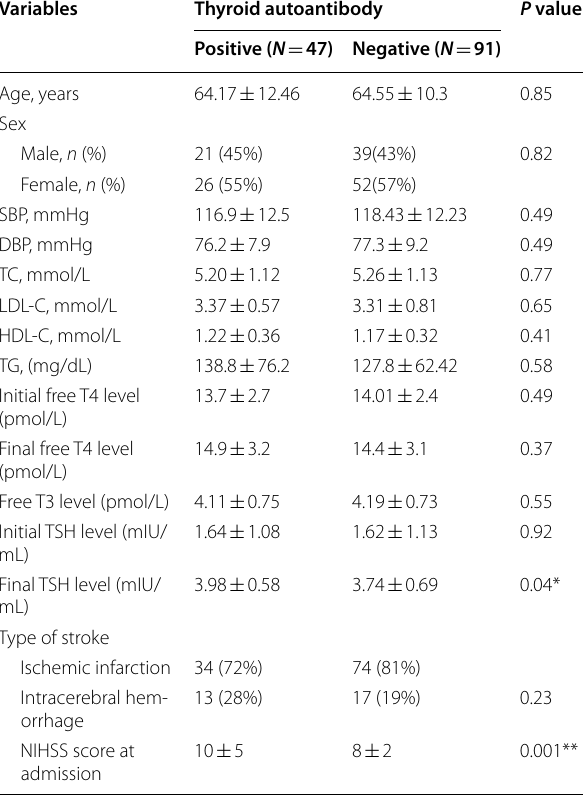
Table 1 Comparison of clinical parameters of acute stroke patients with positive thyroid autoantibody and those with negative thyroid autoantibody